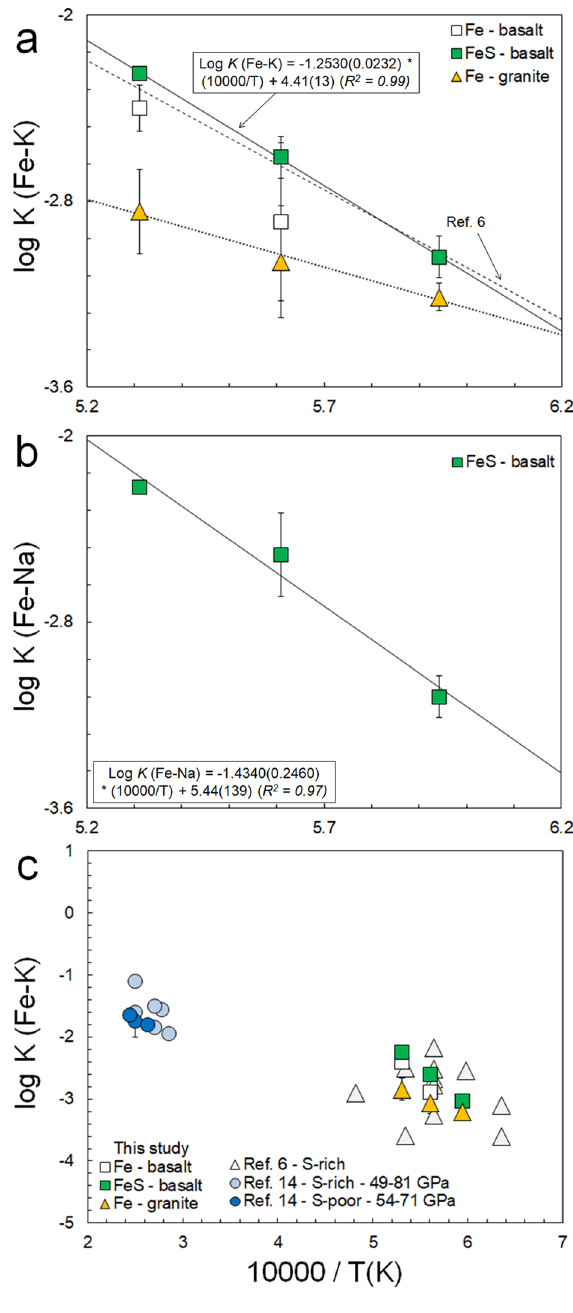
Figure 2. ( a – c) Sulfide-silicate and metal-silicate equilibrium constants for K and Na as a function of temperature (in Kelvin) from this study, Murthy et al . 6 and Blanchard et al . 14 . Solid line in ( a , b ) are the best-fit dependency for the FeS – basalt data. Errors represent 2 standard errors and were calculated by simple error